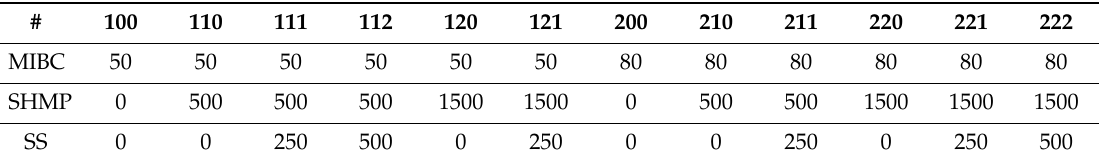
Table 2. Design of experiment (DoE) used in this study showing dosages of reagents (g.t − 1 ) in individual flotation